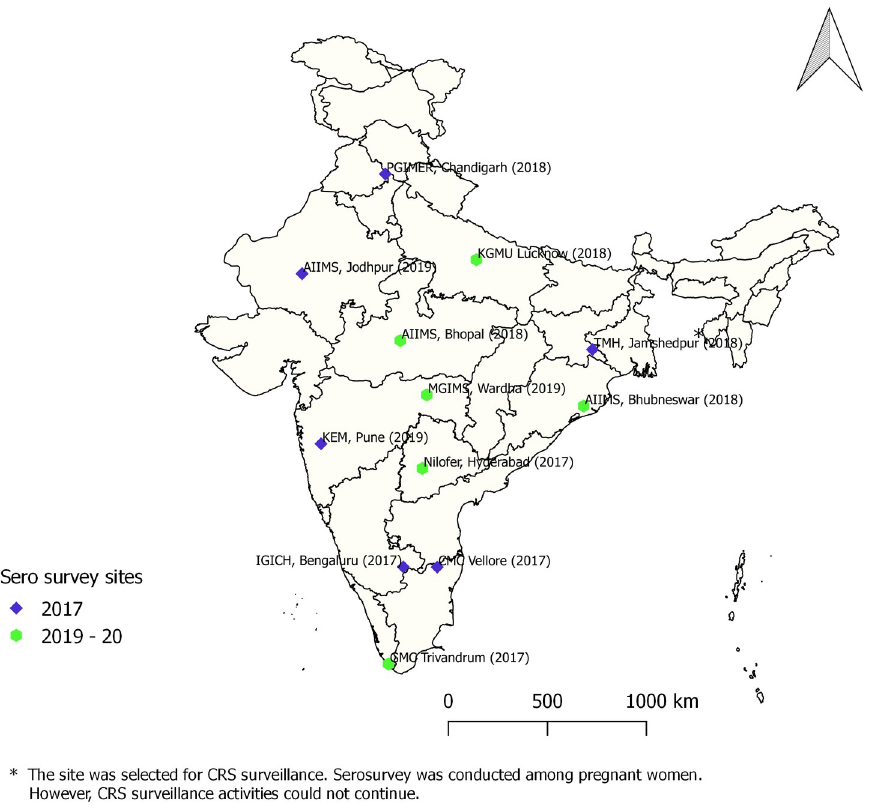
Fig 1. Location of CRS sentinel surveillance sites and year of MRCV SIA in